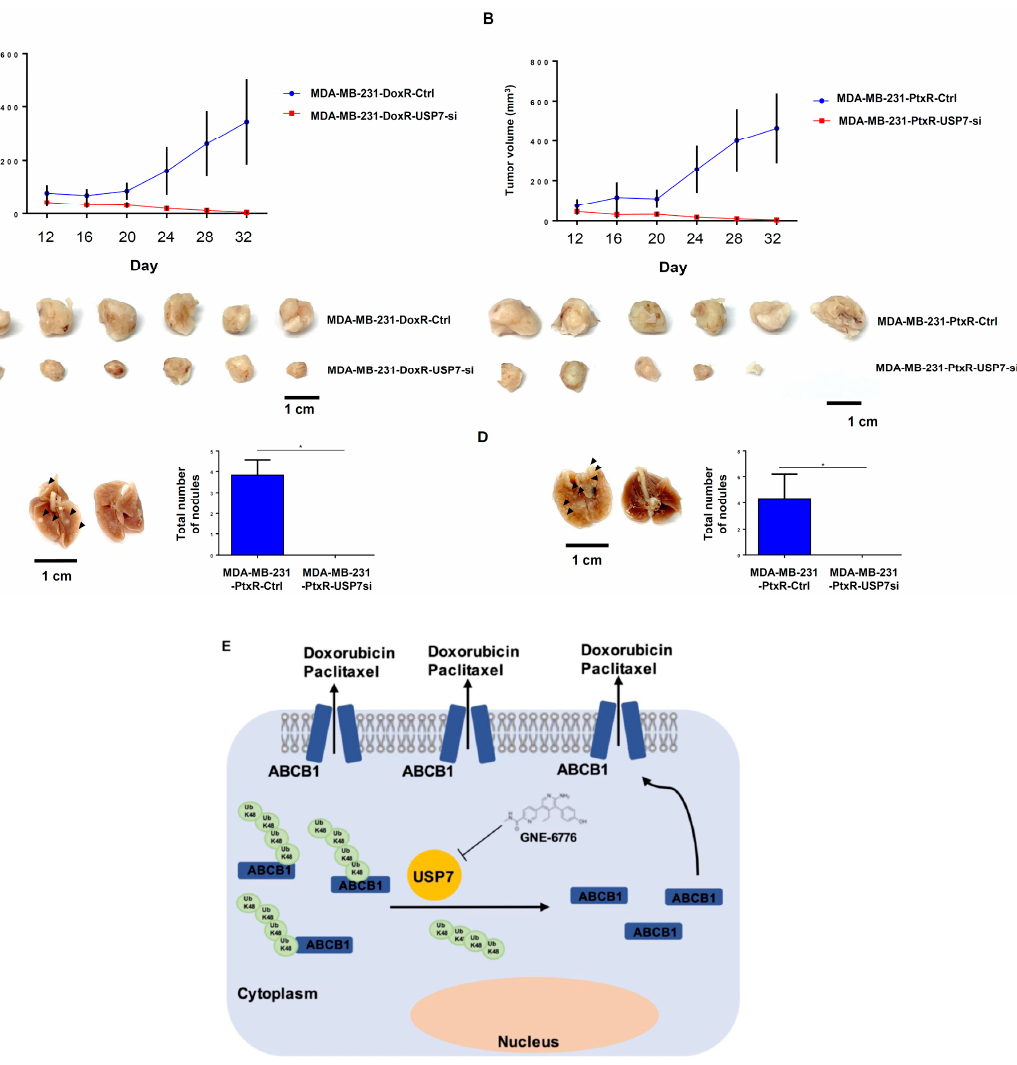
Figure 10. Regulation by USP7 of tumor growth and lung metastasis in chemoresistant TNBC in an orthotopically xenograft animal model. ( A , B ) MDA-MB-231-DoxR USP7-silencing and MDA-MB- 231-PtxR-USP7-silencing cells were orthotopically injected into Nod SCID mice. Tumor volumes were measured every four days and calculated using the formula V = (L × W 2 )/2. Six mice per group. ( C , D ) Picture of a control lung lobe with metastases and a USP7-silencing group lung lobe without metastases. ( E ) A graphic model for the finding in this report. Data are represented as the mean ± SD for animal experiments. * p < 0.05, compared with the results for MDA-MB-231-DoxR-ctr1 and MDA-MB-231-PtxR-ctrl